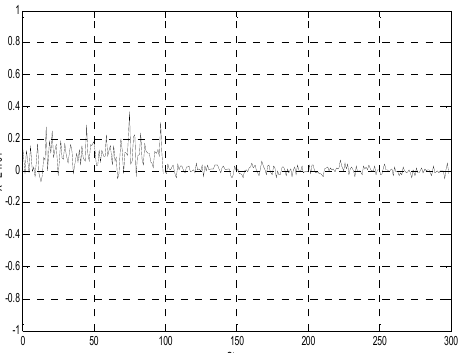
Figure 5. X-position estimates (the first 100 steps using the extended Kalman filtering method without